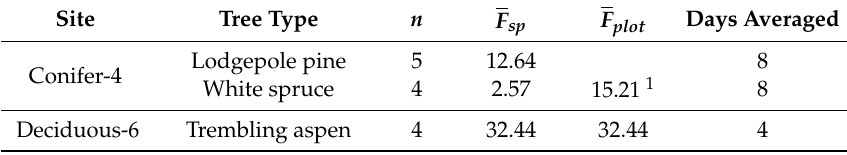
Table 1. F sp and F plot (m 3 day − 1 ) at each site ( n is the number of individuals used per plot). Site Tree Type n F sp F plot Days Averaged Lodgepole pine 5 Conifer-4